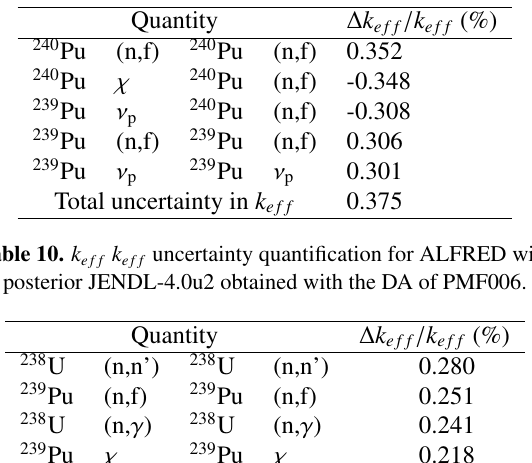
Table 9. k ef f uncertainty quantification for ALFRED with posterior JEFF-3.3 obtained with the DA of PMF002.